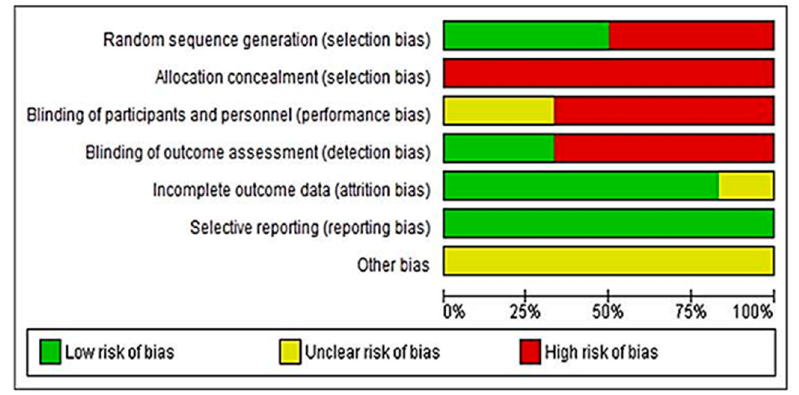
Figure 3. Overall risk of bias. Each category is presented by percentages.